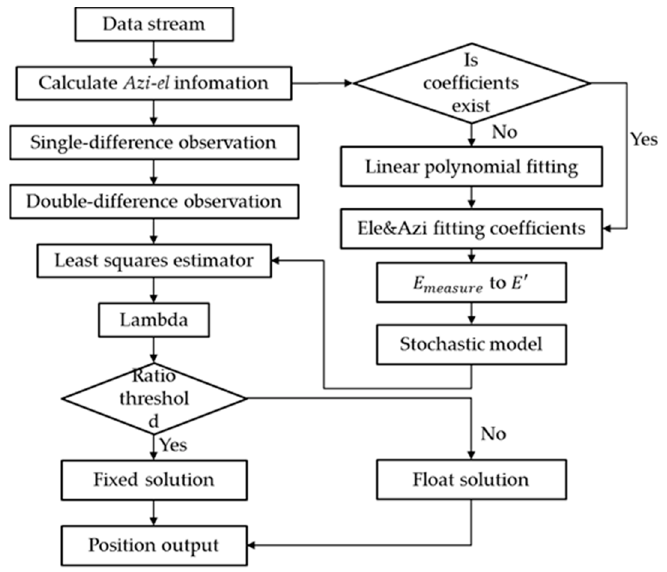
Figure 5. Flowchart of the real-time kinematic (RTK) technique under the ADEW model.